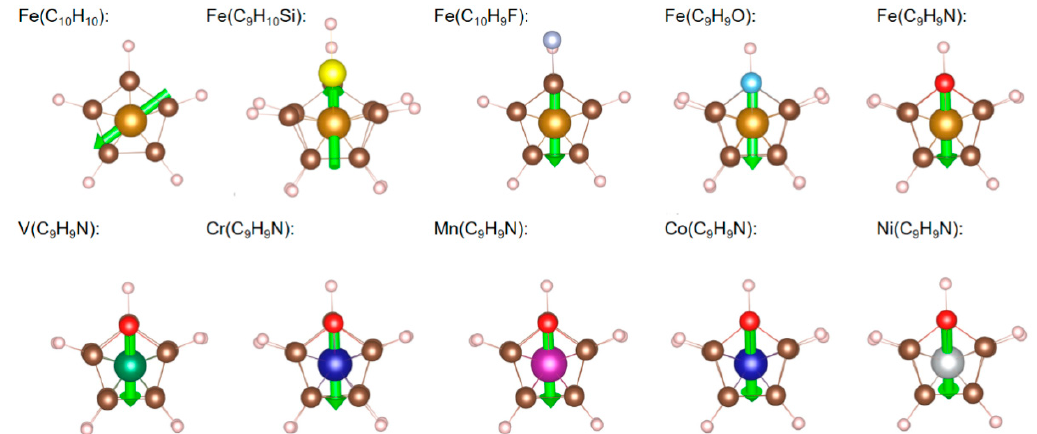
Figure 1. The structure and dipole moments of isolated Fe(C 10 H 10 ), Fe(C 9 H 10 Si), Fe(C 10 H 9 F), Fe(C 9 H 9 O), Fe(C 9 H 9 N), V(C 9 H 9 N), Cr(C 9 H 9 N), Mn(C 9 H 9 N), Co(C 9 H 9 N), and Ni(C 9 H 9 N) molecules with an eclipsed starting configuration. The green arrows denote the direction of the dipole moment for each molecule. Key: C: brown; Fe: shallow brown; H: pink; O: light blue; N: red; V: cyan; Cr: dark blue; Mn: purple; Co: blue; Ni: silver. Table 2. Number of 3 d electrons on the transition metal (TM) ions (N); magnetic moment (M, μ B), dipole moment ( μ , D) of isolated metallocene molecules; rotation barriers ( E rotation = E staggered – E eclipsed , kJ/mol) and dipole moment differences ( Δμ = μ staggered − μ eclipsed , D) between the two different configurations.